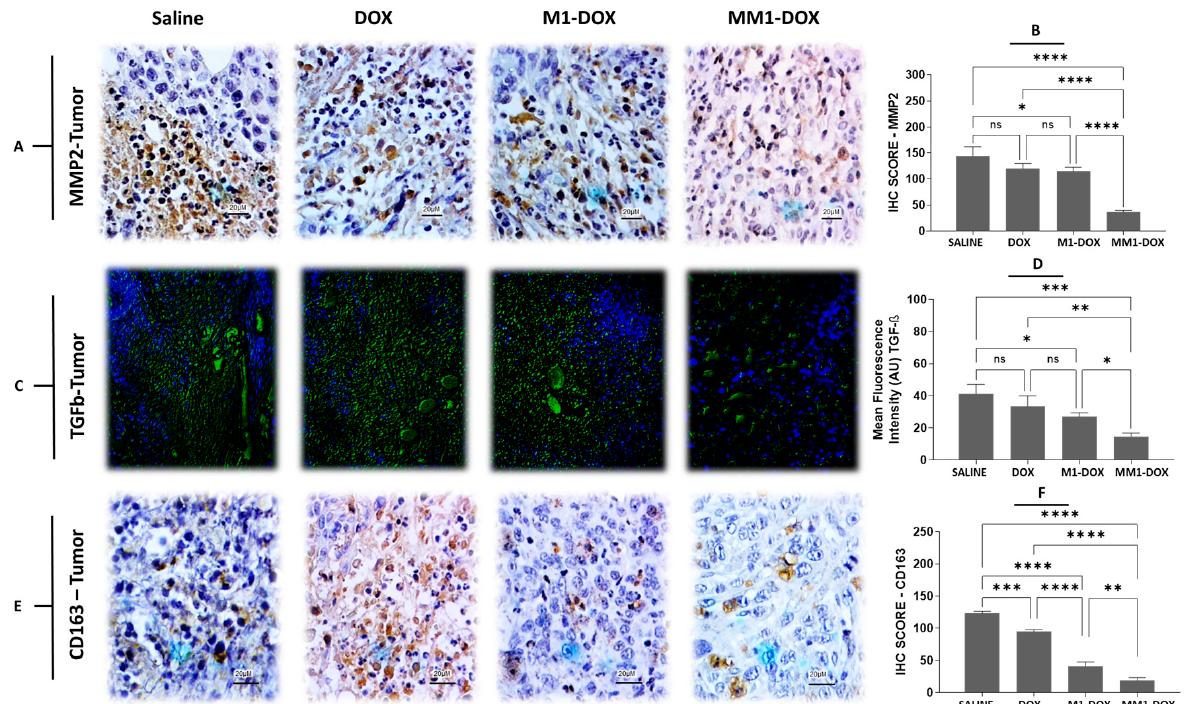
Figure 6. In vivo antimetastatic properties of MM1-derived EVs loaded with DOX in orthotopic 4T1 breast cancer-bearing mice in vivo. ( A ) Immunohistochemical (IHC) detection of MMP-2 in tumor sections from treated animals. ( B ) IHC score for MMP-2 from the four experimental groups. ( C ) Immunofluorescence detection of tumor growth factor beta (TGF- β ) in tumor sections of treated animals. ( D ) Mean fluorescence intensity of TGF- β in the four experimental groups. ( E ) IHC detection CD163 in tumor sections from treated animals. ( F ) IHC score for CD163 from the four experimental groups. Scale bars are 20 µ M. Data are means ± SEM ( n = 5 mice per condition). Non-significant (ns); **** p < 0.0001; *** p < 0.001; ** p < 0.01; * p < 0.05.